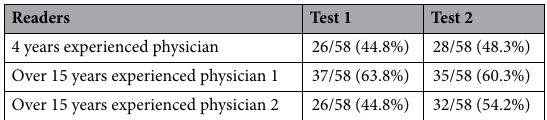
Table 3. Accuracy of three physicians in two Turing tests.